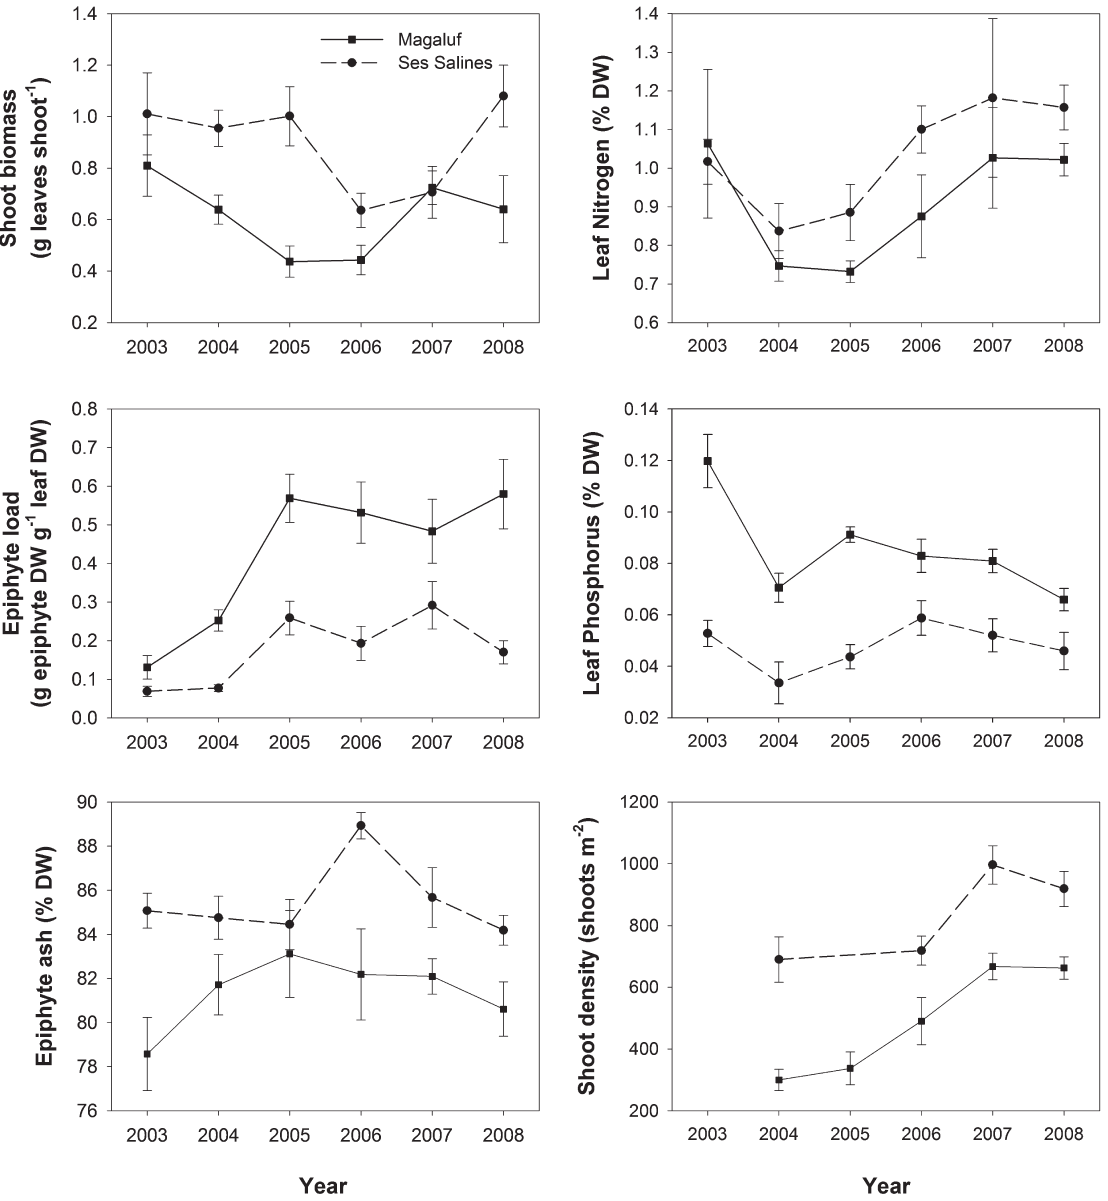
Fig . 2. – Shoot biomass, epiphyte load, ash content of the epiphytes, nitrogen and phosphorus content of the leaves and shoot density of Posidonia oceanica at Magaluf and Ses Salines, Mallorca (western Mediterranean) from 2003 to 2008. Error bars represent ± 1 standard error. The year 2005 was not included in the analysis of shoot density because no data were collected at Ses Salines that